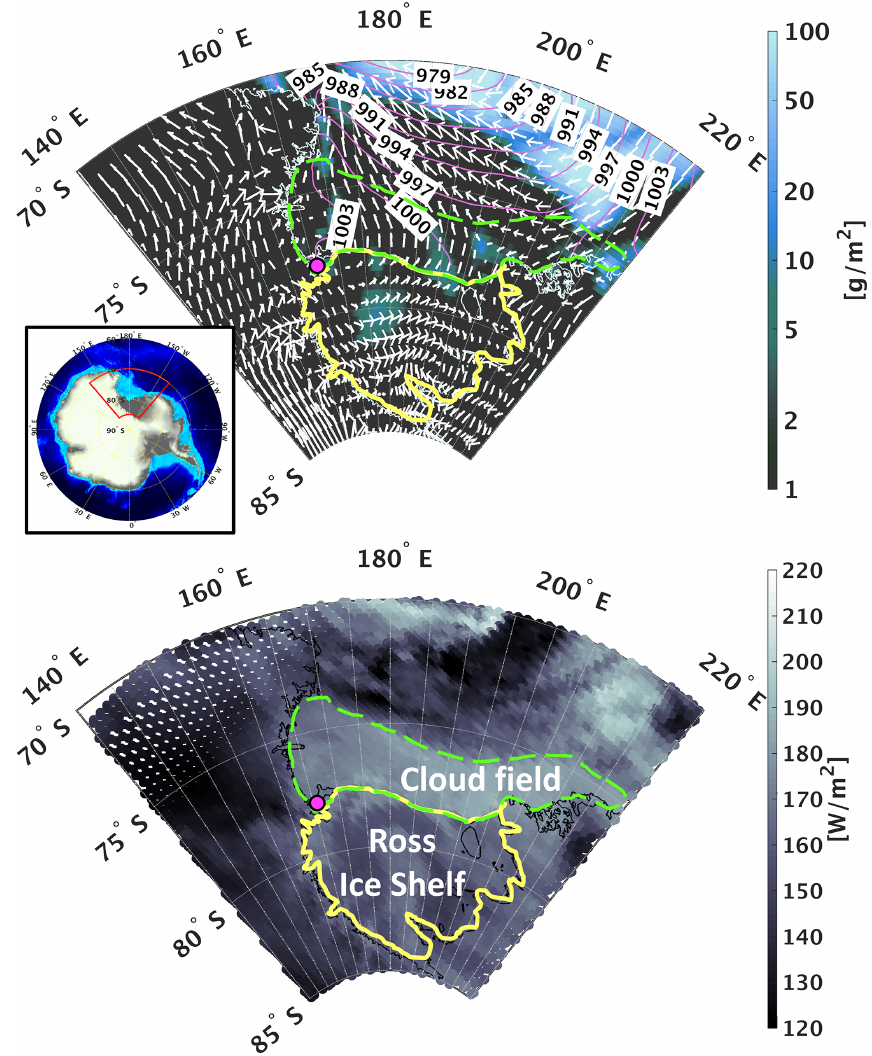
Figure 2. (Top) Sea level pressure (contours; land areas are masked), total condensate water path (logarithmic color scale), and surface winds (quivers) resolved by ERA5 (Hersbach et al., 2020) for 16 August 2016, at 10:00–11:00UTC. The magenta-filled marker denotes McMurdo Station. The dashed green shape highlights a widespread cloud field along the Ross Ice Shelf (yellow shape) coast associated with the ground-based observations. The inset panel shows a topographic map of Antarctica (the red box highlights the region depicted in the main panel). (Bottom) Top of atmosphere upwelling longwave radiation measured by CERES Aqua on 16 August 2016, at 10:44–10:50UTC. The 1arcmin topographic data were developed by the National Geophysical Data Center (NGDC Amante, 2009) and are freely available at https://www.ngdc.noaa.gov/mgg/global/global.html (last access: 1 December 2021). Reproduced from Silber et al.